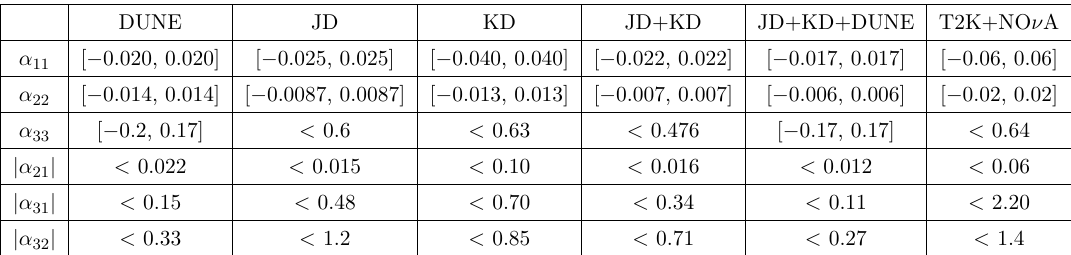
Table 6 . Bounds on the NUNM parameters at 90% C.L. (1 d.o.f.) using DUNE (second column), JD (third column), KD (fourth column), and JD+KD (fifth column). Sixth column shows the results for the combination of DUNE and JD+KD. Last column depicts results using the full exposure of T2K and NO ν